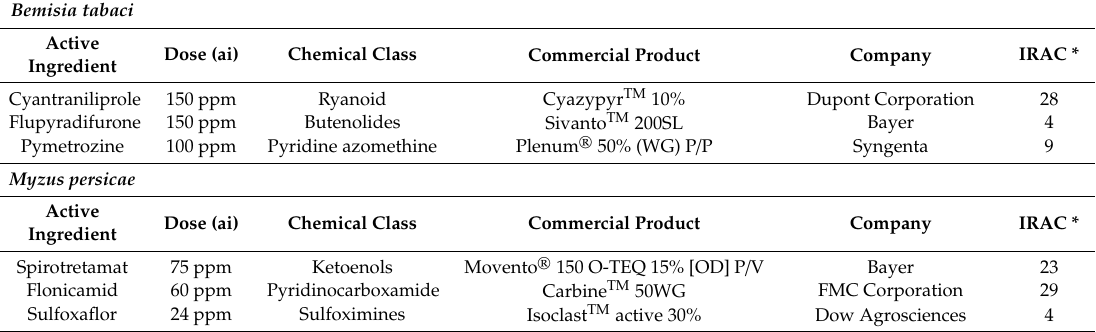
Table 3. Systemic insecticides tested in laboratory experiments against Bemisia tabaci and Myzus persicae. *, Mode of action according to Insecticide Resistance Action Committee (IRAC)